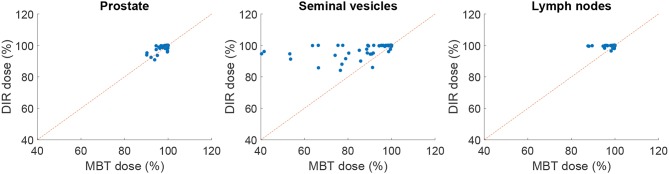
Scatter plot comparing elastix DIR (100 iterations) with MBT, in terms of dosimetric coverage (V95%). The red line indicates the line of no change, i.e., points above this line indicate improvement of DIR over MBT.